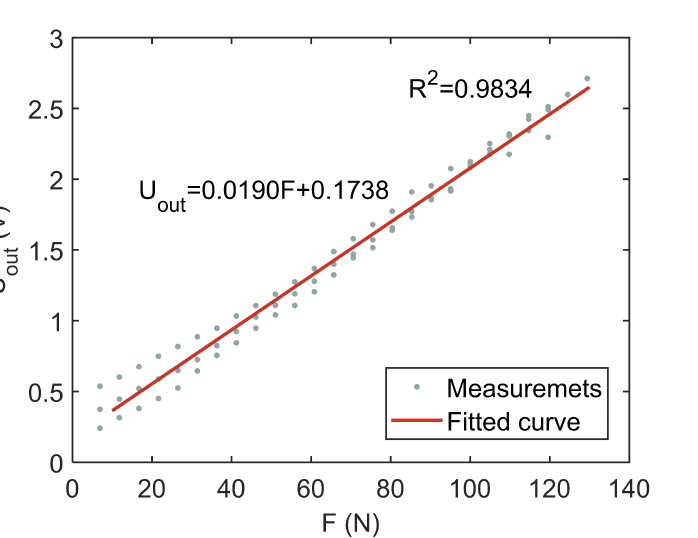
Figure 8. Relationship between force sensor voltage and loading force. Each measurement point represents the average of 200 measurements. U out represents the offset and amplified voltage.